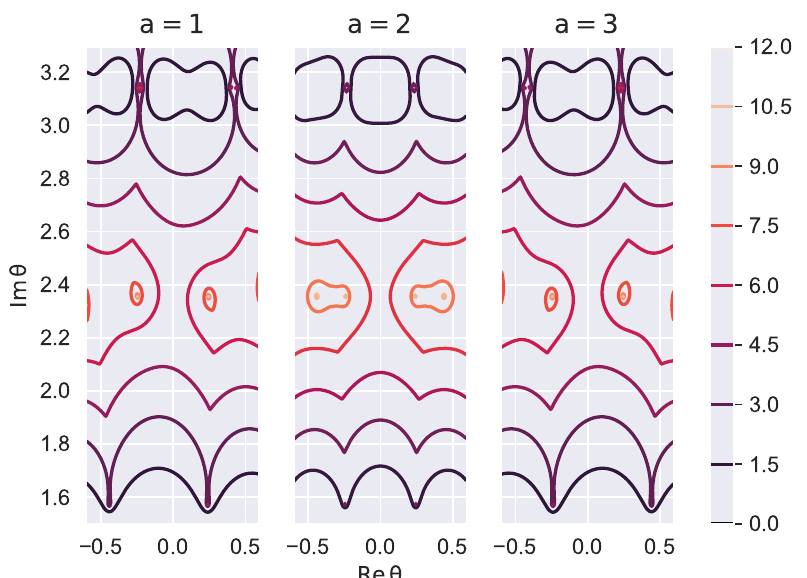
Figure 2 . Contour plot of | log(1 + e Y a, 2 ( θ )) | in the seven-point case for the three possible values of a . Points of dense contour lines correspond to singular points of the Y -system, with singular points in the vicinity of Im θ = π and π corresponding to singularities of the type e Y 2 singularities around Im θ = 3 π corresponding to singularities of the type e Y 4 locations satisfy the relations indicated in the middle column of table